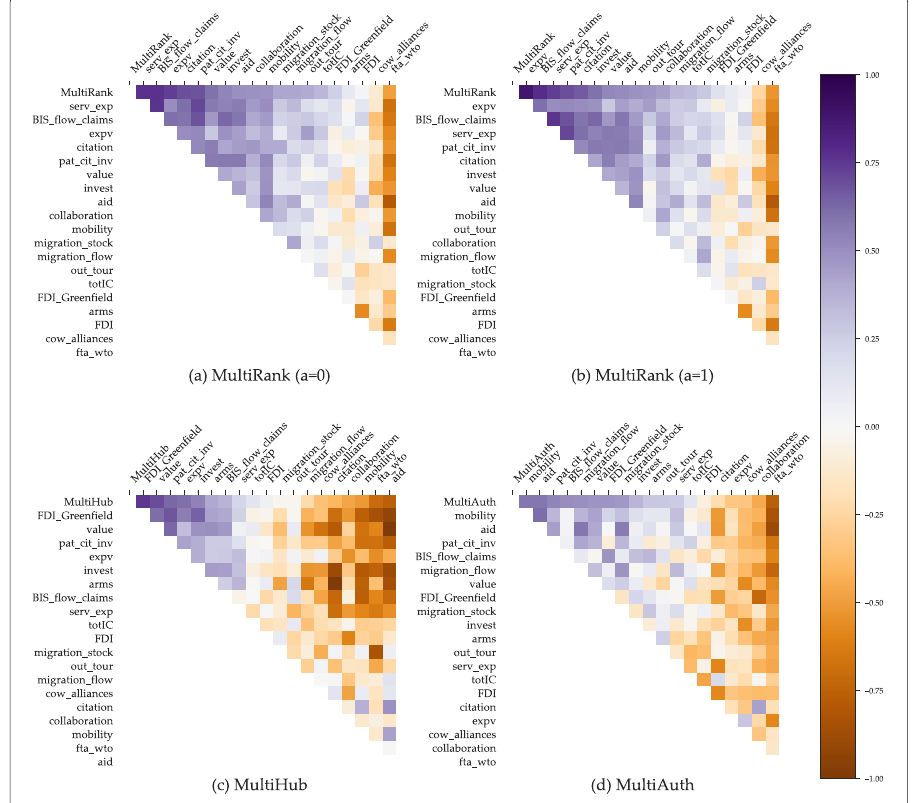
Fig. 3 Spearman correlation of the node rankings obtained by calculating centrality measures on both the single layers and the multiplex (hence using the multiplex version of the algorithms). For the MultiRank rankings the other parameters are in both cases s = 1 and γ = 1.All results refer to the cross section in 2003, results for the cross section 2010 are available in the